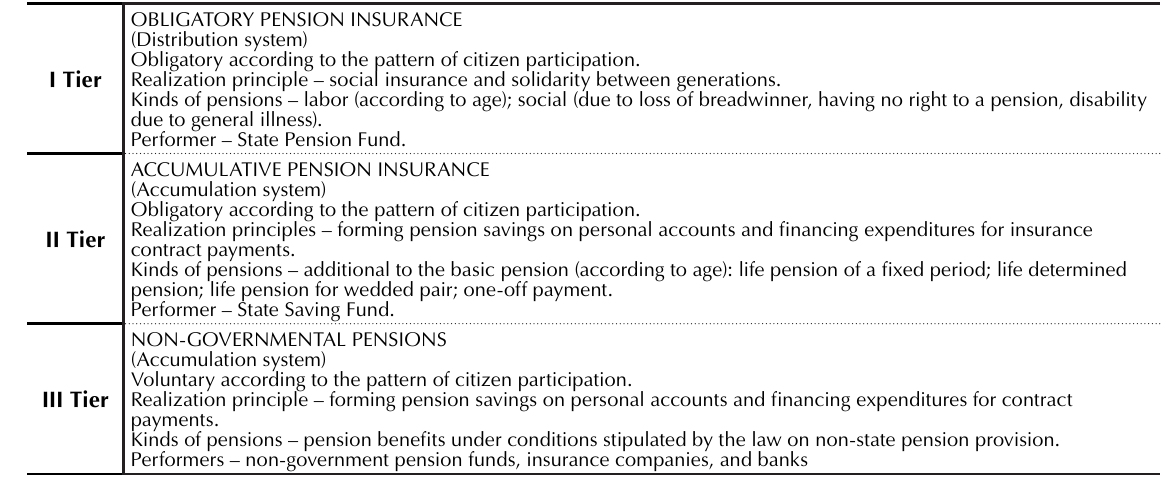
Source: Compiled by the